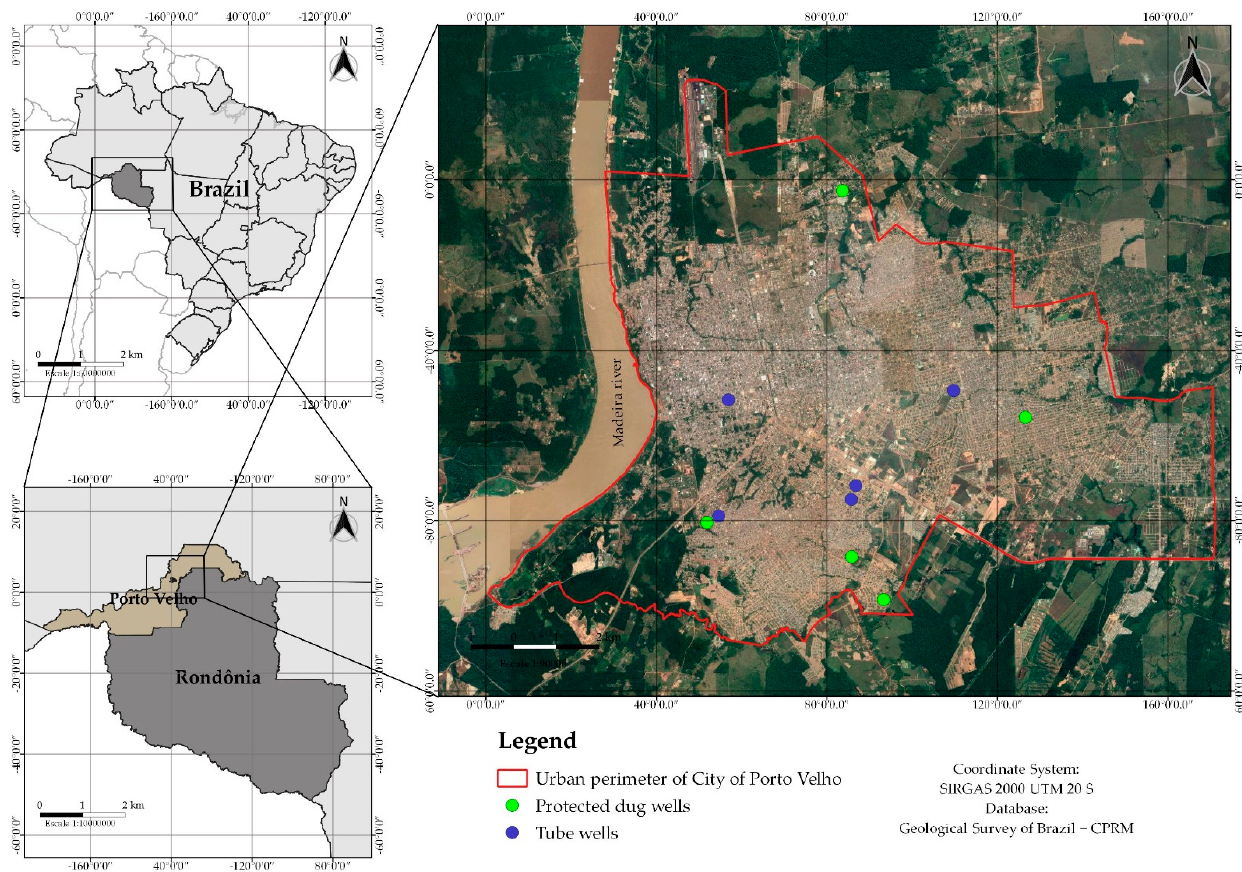
Figure 1. Study area showing the sampled wells in Porto Velho.